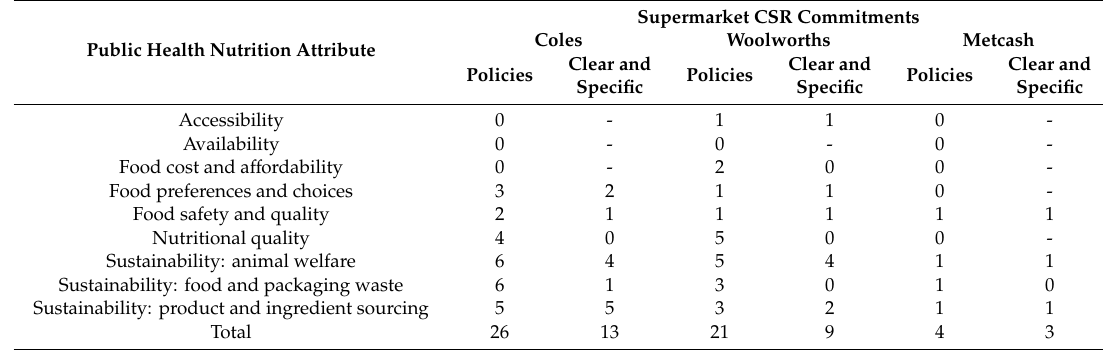
Supermarket CSR Commitments Coles Woolworths Metcash Clear and Clear and Clear and Policies Policies Policies Specific Specific Specific